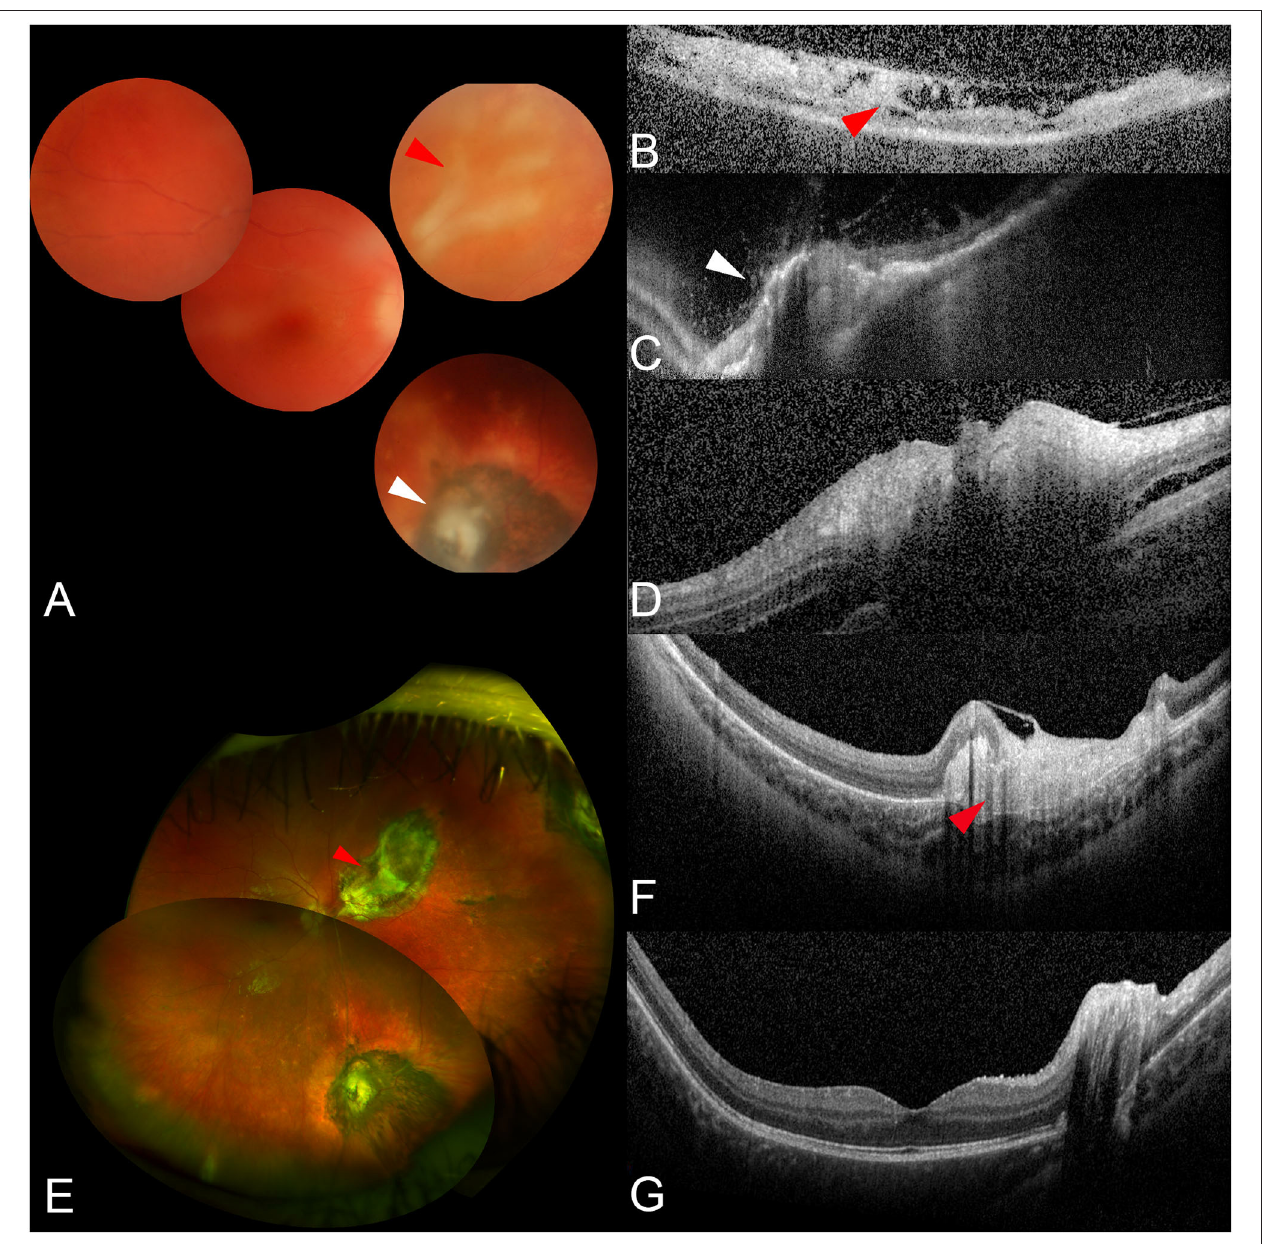
FIGURE 2 | Ophthalmic images from case 2. At presentation, despite the vitritis, it is possible to distinguish areas of retinitis ( A , red arrowhead) and a pigmented chorioretinal scar ( A , white arrowhead) through fundus examination (A) . Optical coherence tomography (OCT) scans confirm the presence of inflammatory hyper-reflective material and retinal layer disorganization on the areas of retinitis ( B , red arrowhead), and retinal atrophy with pigment clumping on the chorioretinal scar ( C , white arrowhead). Finally, an OCT scan through the optic disc shows a swollen nerve head with peripapillary subretinal fluid (D) . After treatment, the vitritis resolved and a large chorioretinal atrophy is now visible in correspondence of the previous retinitis in both fundus examination ( E , red arrowhead) and OCT ( F , red arrowhead). OCT also shows a physiologic macular profile (G) .